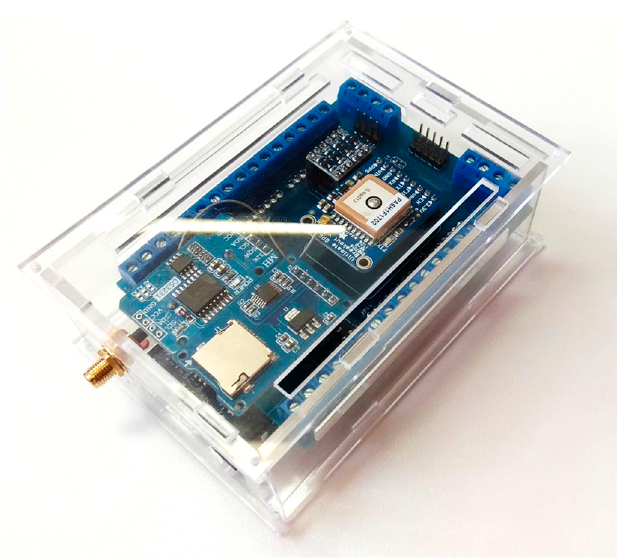
Figure 2. LC-DAQ system with all the modules installed.